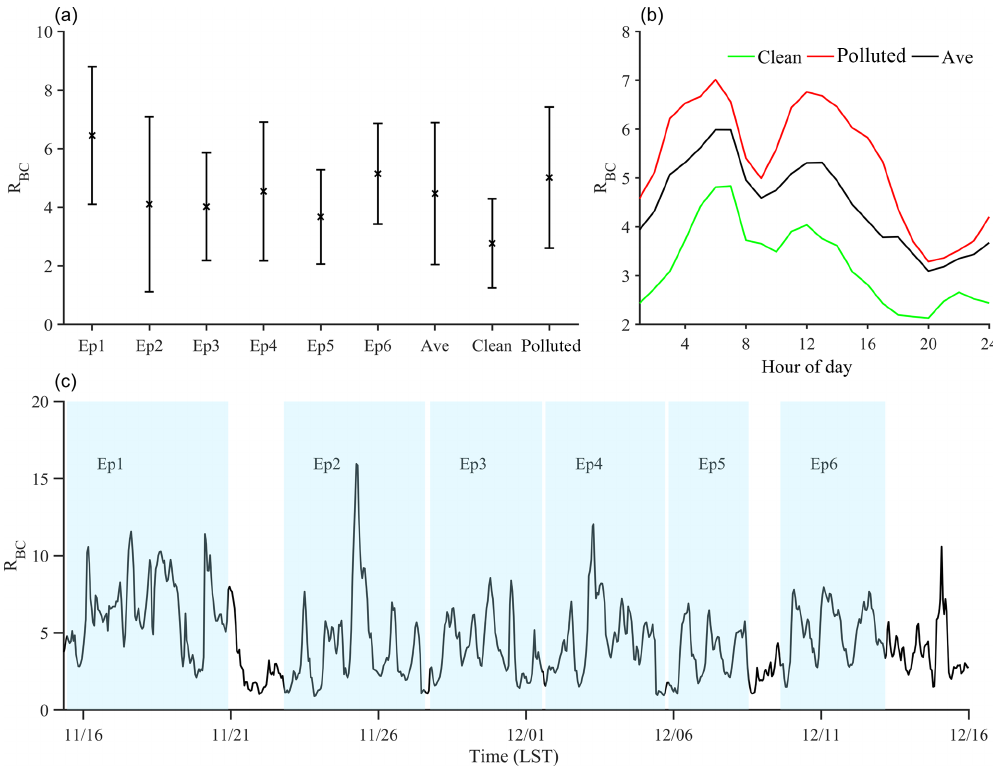
Figure 11. (a) Average and standard variation of the mass ratio of the coating of BC to BC ( R BC ) during different episodes and pollution levels. (b) Diurnal cycles of R BC under different pollution levels. (c) Temporal variation of R BC during study period. “Ave” refers to the average over the whole study